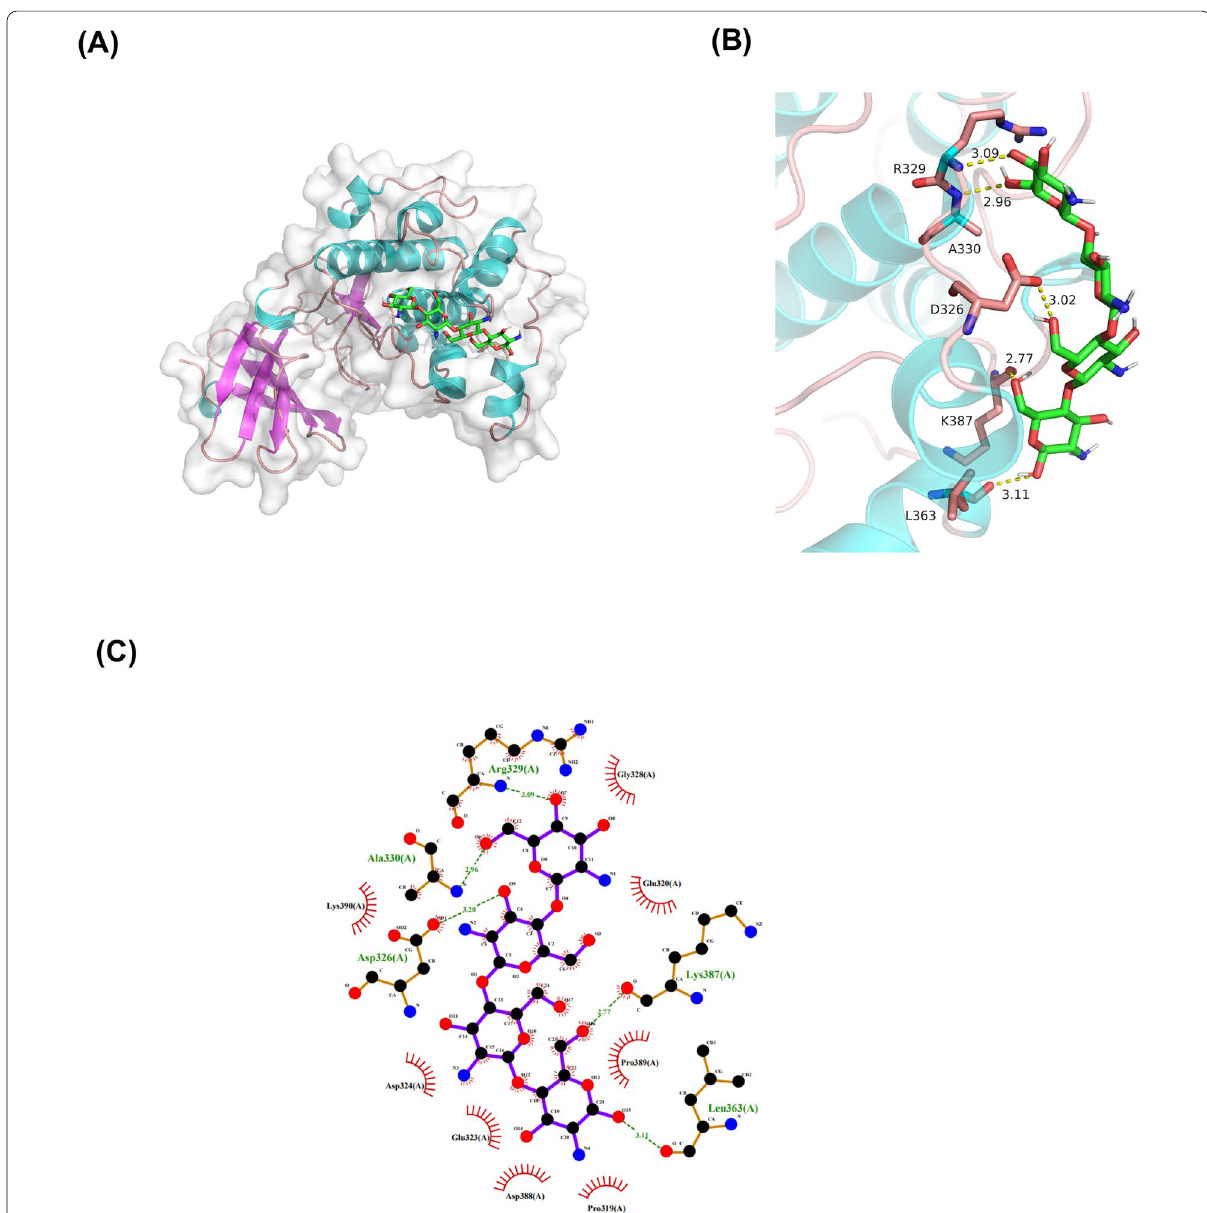
Fig. 12 The predicted optimal binding mode of the COS docked with Akt/PKB. A Surface representation, B details of the interactions, C 2D interaction